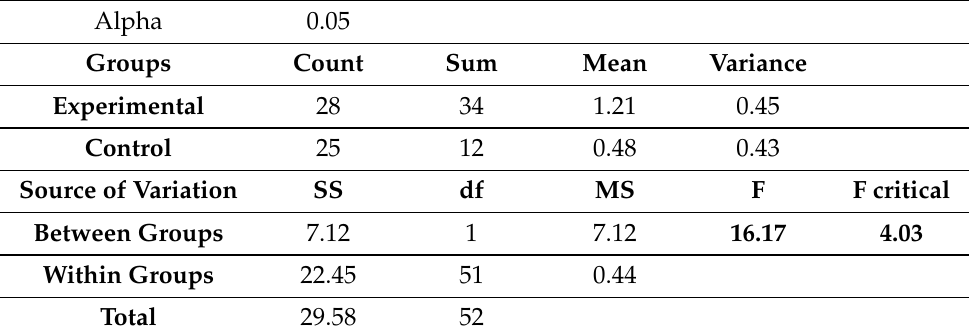
Figure 17. Correct answers in total per task (l) and quartile graphs for points gained (r). Table 7. ANOVA (single factor) results for the Combinational block achievement tests comparison.